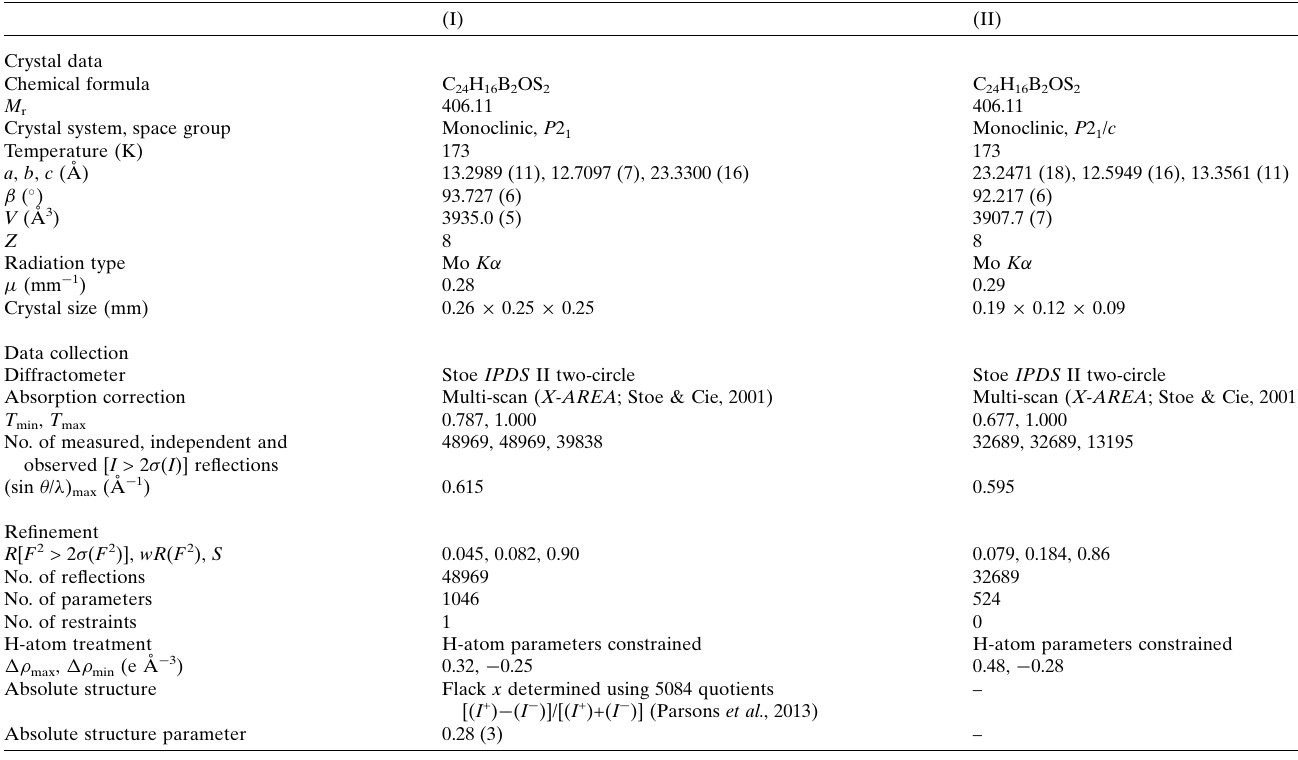
Table 2 Experimental